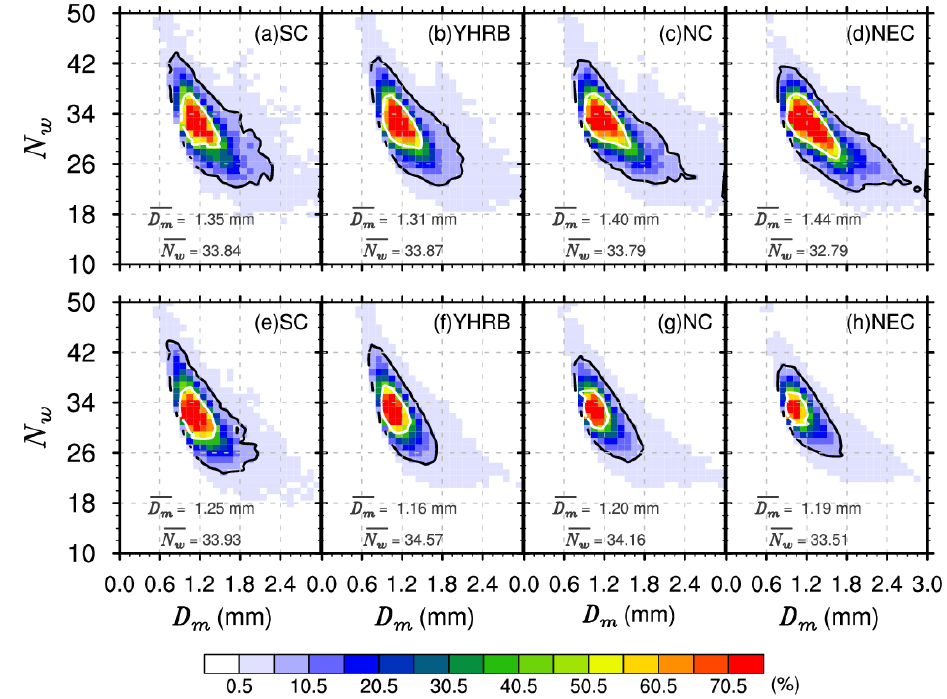
Figure 5. Frequency pattern in two-dimensional space of D m and N w at 1 km above the SH over ( a , e ) SC, ( b , f ) YRHB, ( c , g ) NC and ( d , h ) NEC for LPFs (upper panel) and NLPFs (lower panel) during summer in the time period 2014–2021. D m and N w denote the mean D m and N w values at 1 km above the SH, respectively. The 5% and 50% contours are indicated by black and white solid lines, respec- tively.